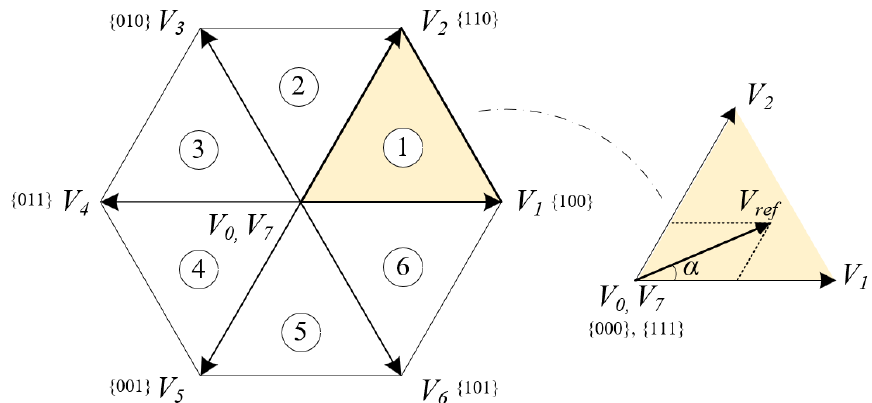
Figure 4. Switching state representation of three-phase SSI based on space-vector approach.